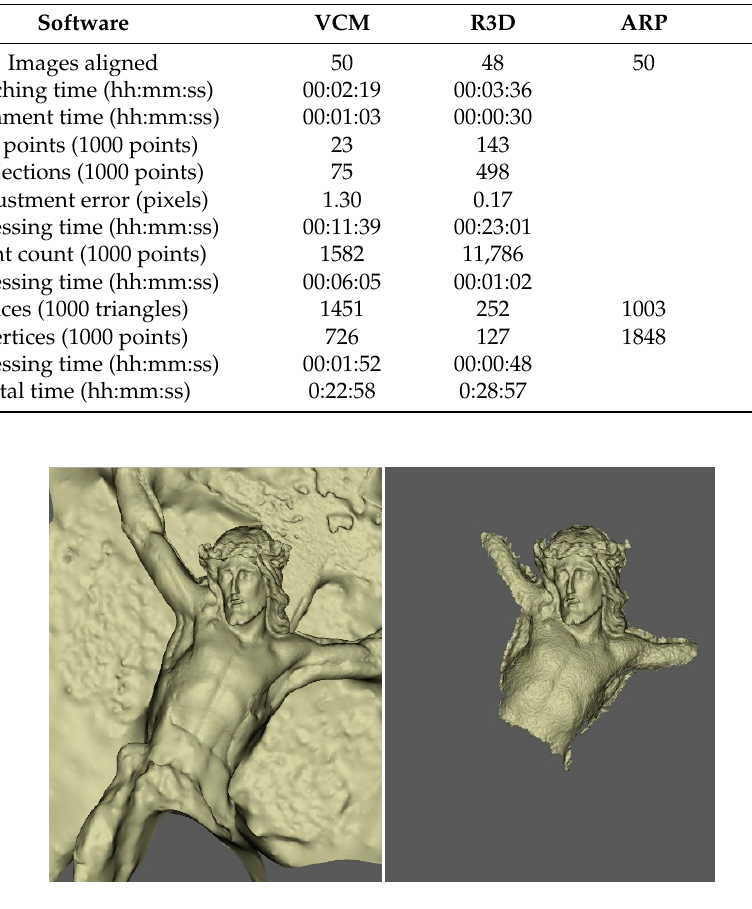
Figure 3. Partial meshes generated with ARP ( left ) and FZA ( right ) from dataset 9.